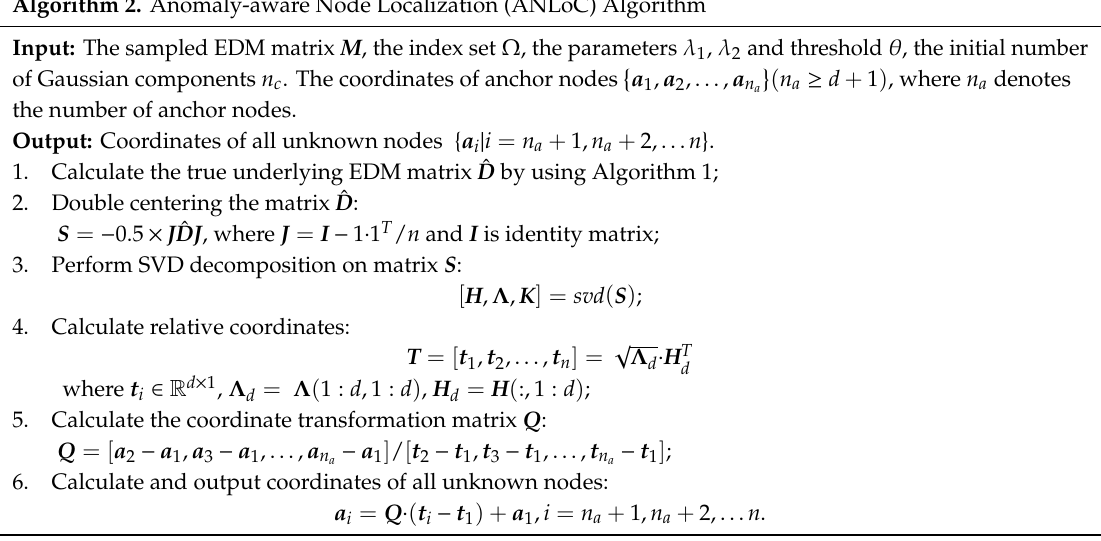
Algorithm 2. Anomaly-aware Node Localization (ANLoC)